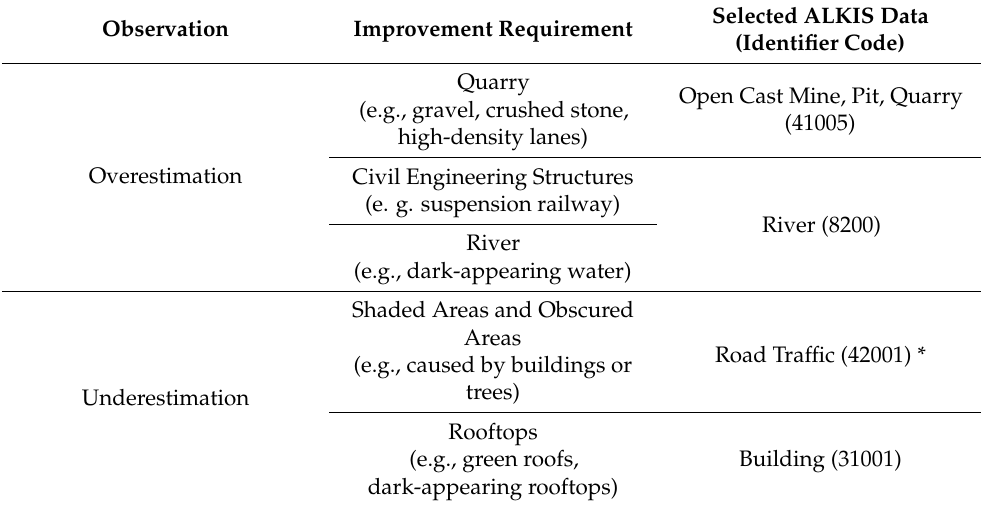
Table 5. Improvement requirements in areas of over- or underestimation of impervious surfaces and the corresponding ALKIS land use data for